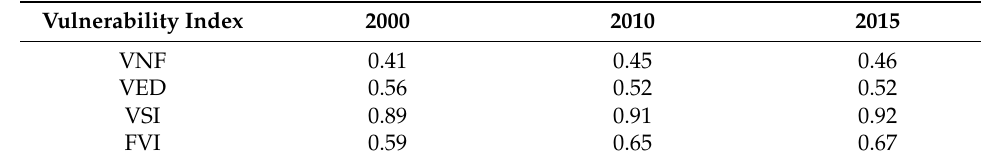
Figure 7. FVI spatial distribution ( left ) and area statistics of the five vulnerability levels ( right ) from 2000 to 2015. The histogram represents the area of each level, and the line chart represents the percentage area of each level. Table 5. Average vulnerability values of the total forest areas in different years.